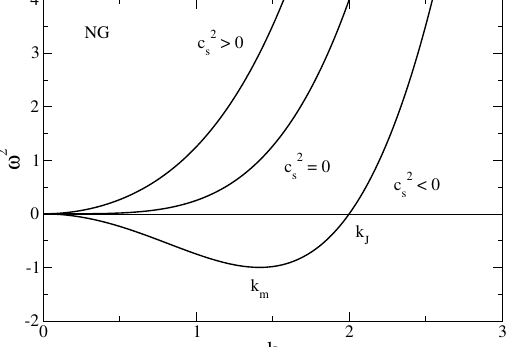
Figure 4. Dispersion relation for dissipationless BECs in the nongravitational limit ( G = 0). We have normalized the wavenumber by ( m 2 | c 2 s | /¯ h 2 ) 1/2 and the pulsation by m | c 2 s | /¯ h . This is equivalent to taking m = | c 2 s | = ¯ h = 1 in the dimensional